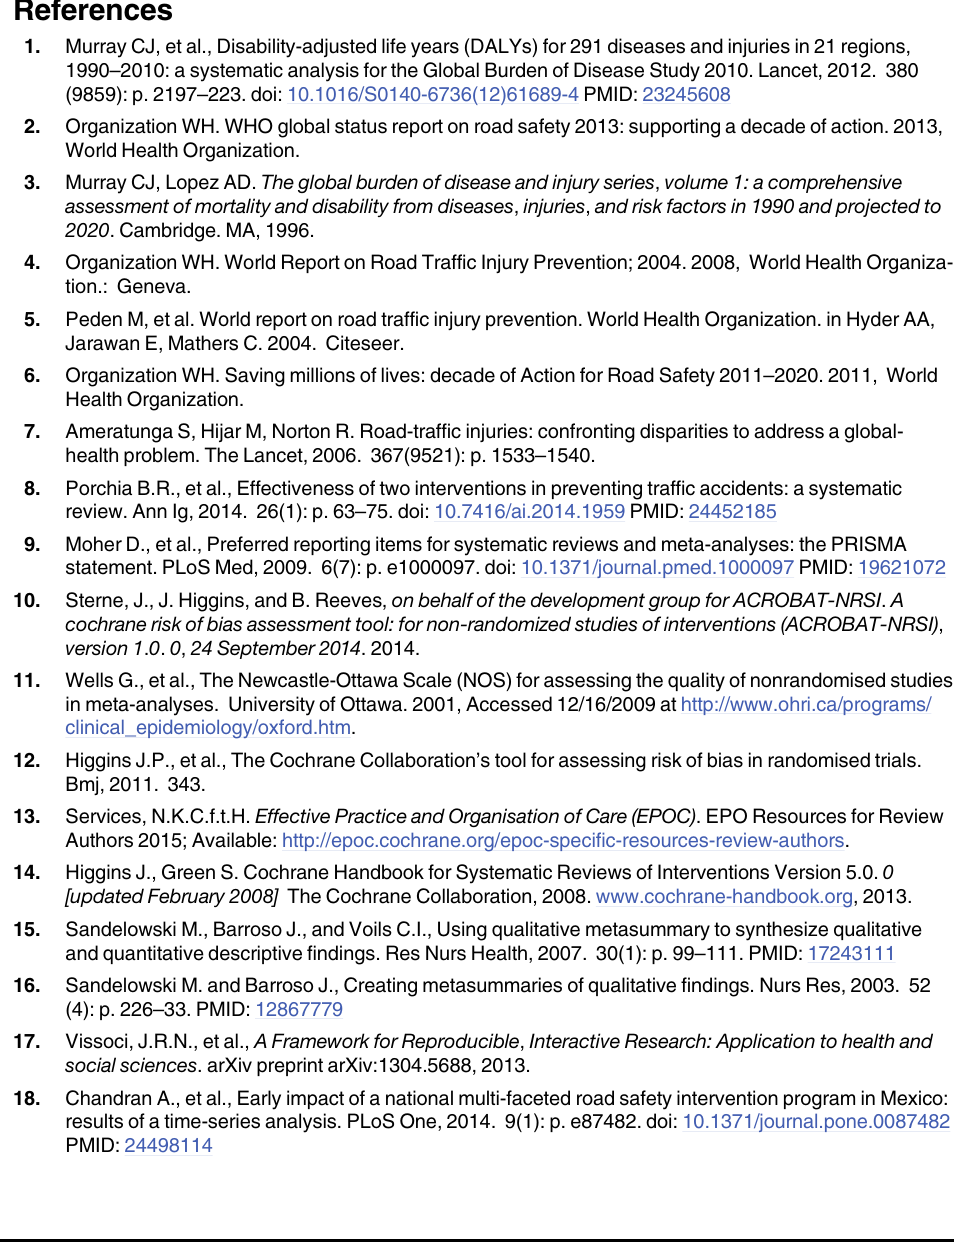
S7 Table. PRISMA